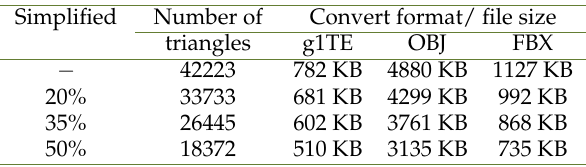
Table 4. Lightweight comparison of distribution cabinet